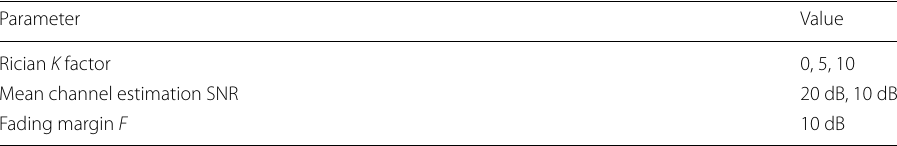
Table 1 Values for numerical